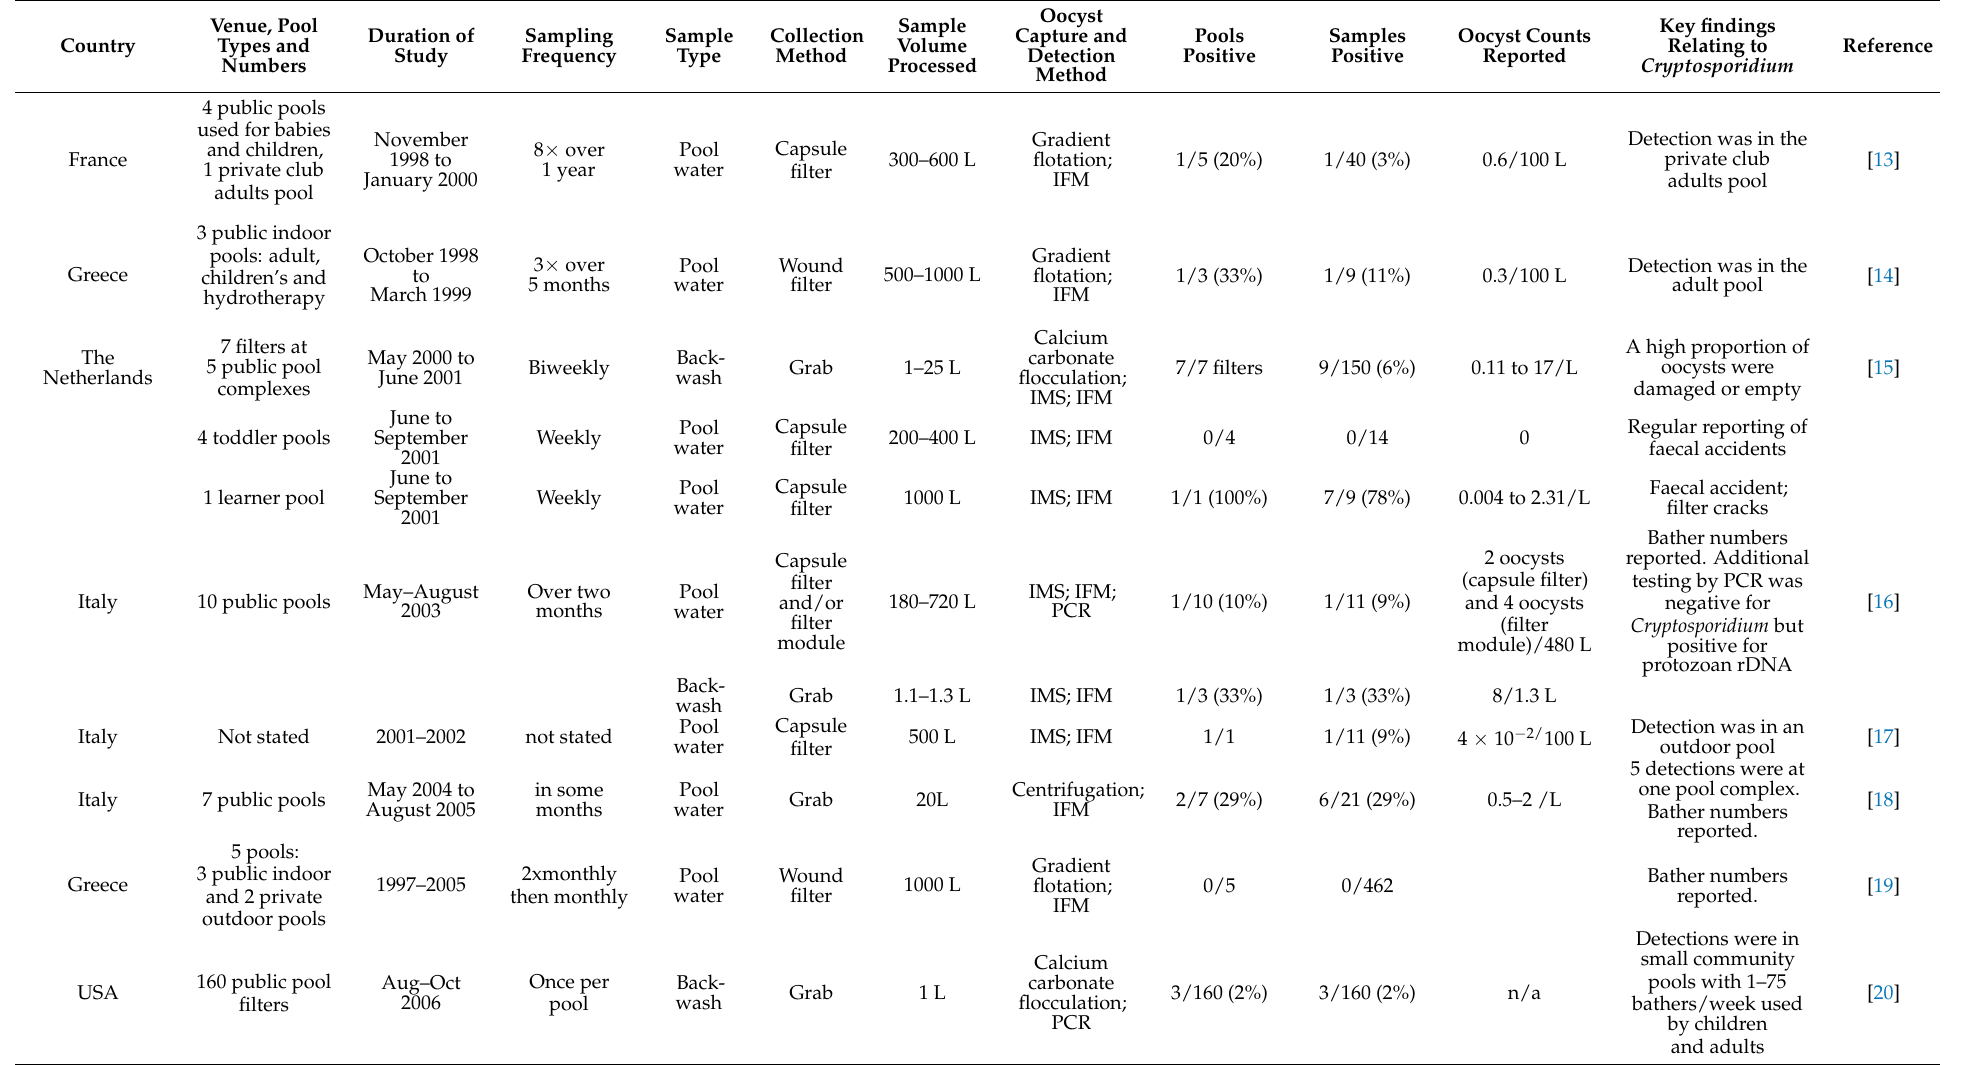
Table 1. Published sample surveys for Cryptosporidium in swimming